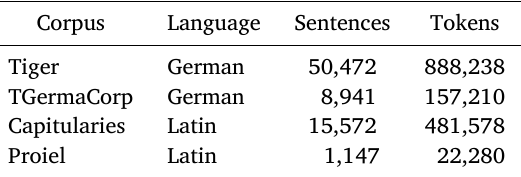
Statistics of corpora used in the